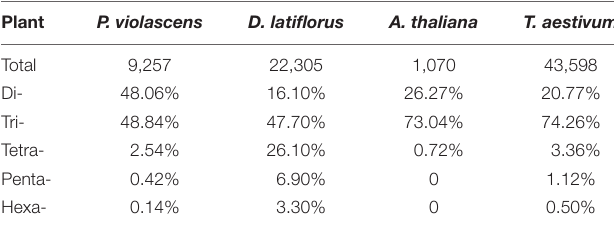
TABLE 2 | Comparison of frequency of microsatellites of Phyllostachys violascens, Dendrocalamus latiflorus, Arabidopsis thaliana, and Triticum aestivum.